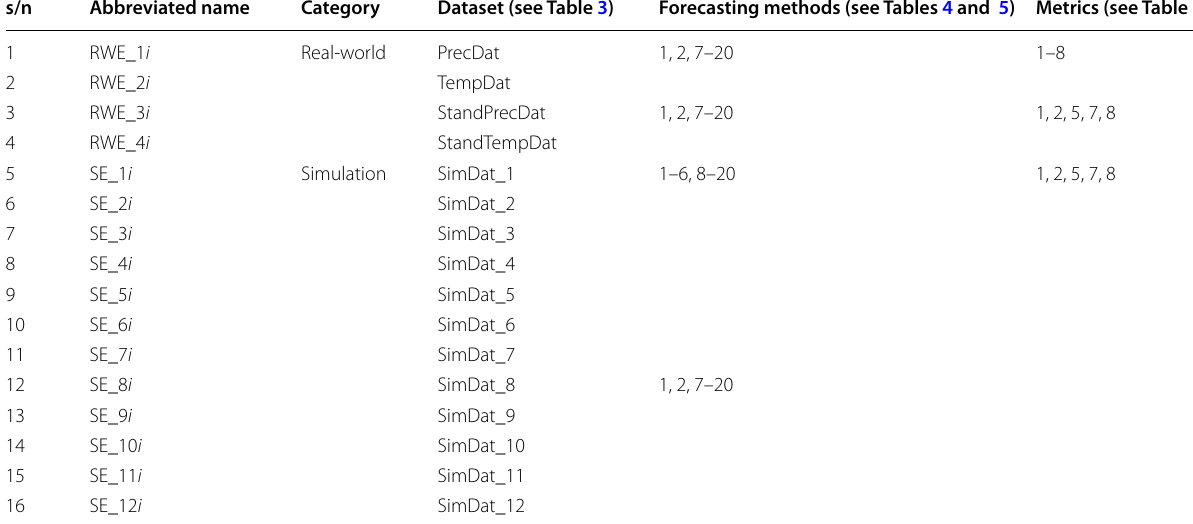
The symbol i can take the values stated in Table